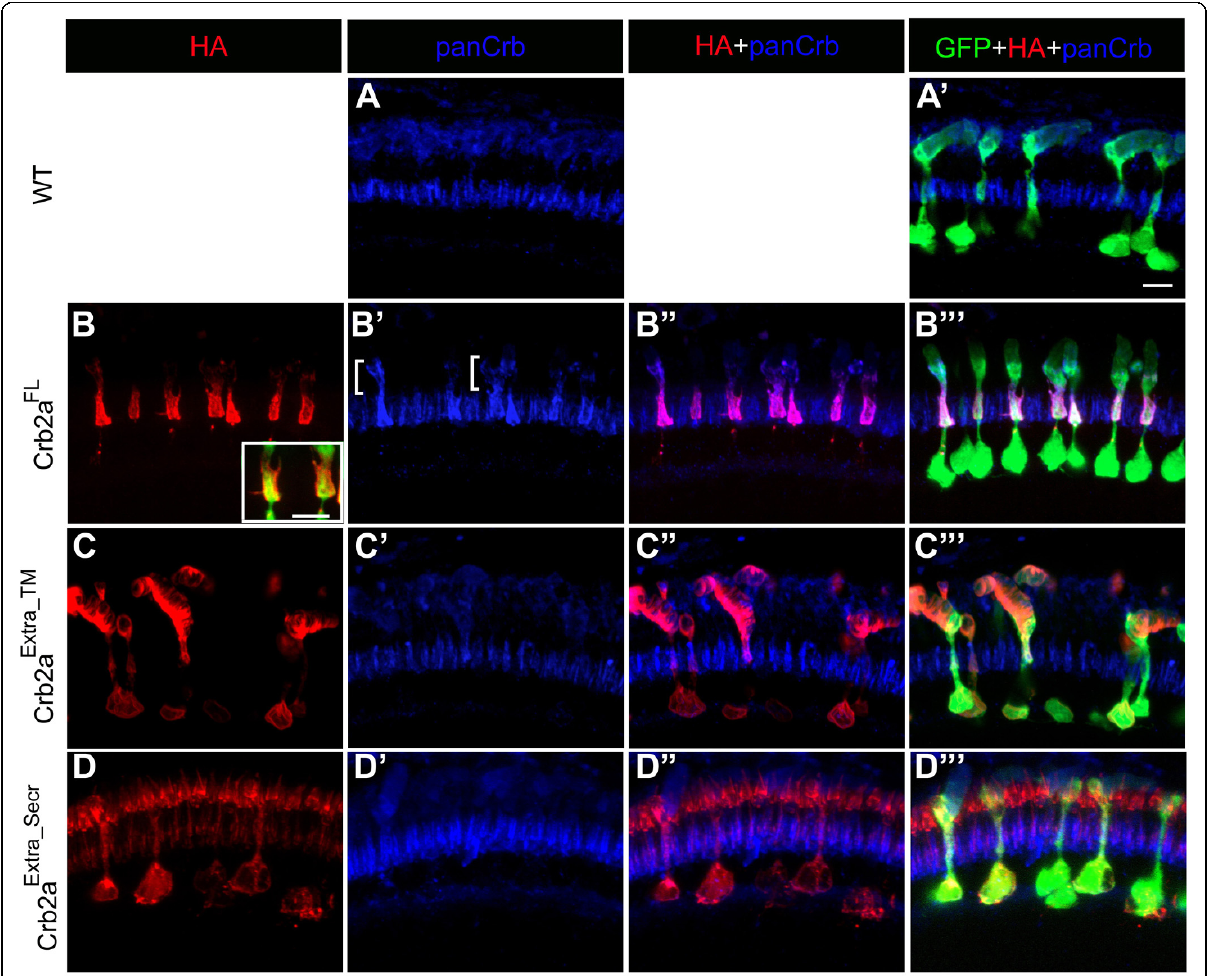
Figure 6 Effects of Crb2a extracellular domain-containing constructs on endogenous Crumbs proteins . (A-D" ’ ) Confocal z-projections of 6 d rods labeled with GFP (green), panCrb (blue) and anti-HA (red) antibodies. (A, A ’ ) Wild-type rods. (B-B" ’ ) Crb2a FL transgenic rods. Inset in B shows fine processes emerging from the inner segment. Bracket in B ’ indicates a region of strong panCrb labeling that is weakly labeled by anti- HA antibodies. (C-C" ’ ) Crb2a Extra_TM transgenic rods. (D-D" ’ ) Crb2a Extra_Secr transgenic rods. Scale bar, 5 μ